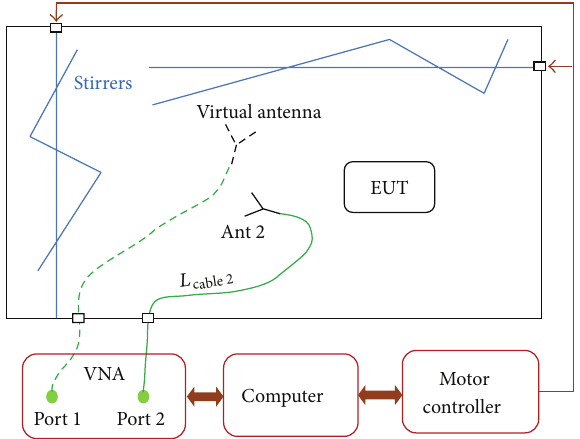
Figure 3: The RE measurement system with VNA and one